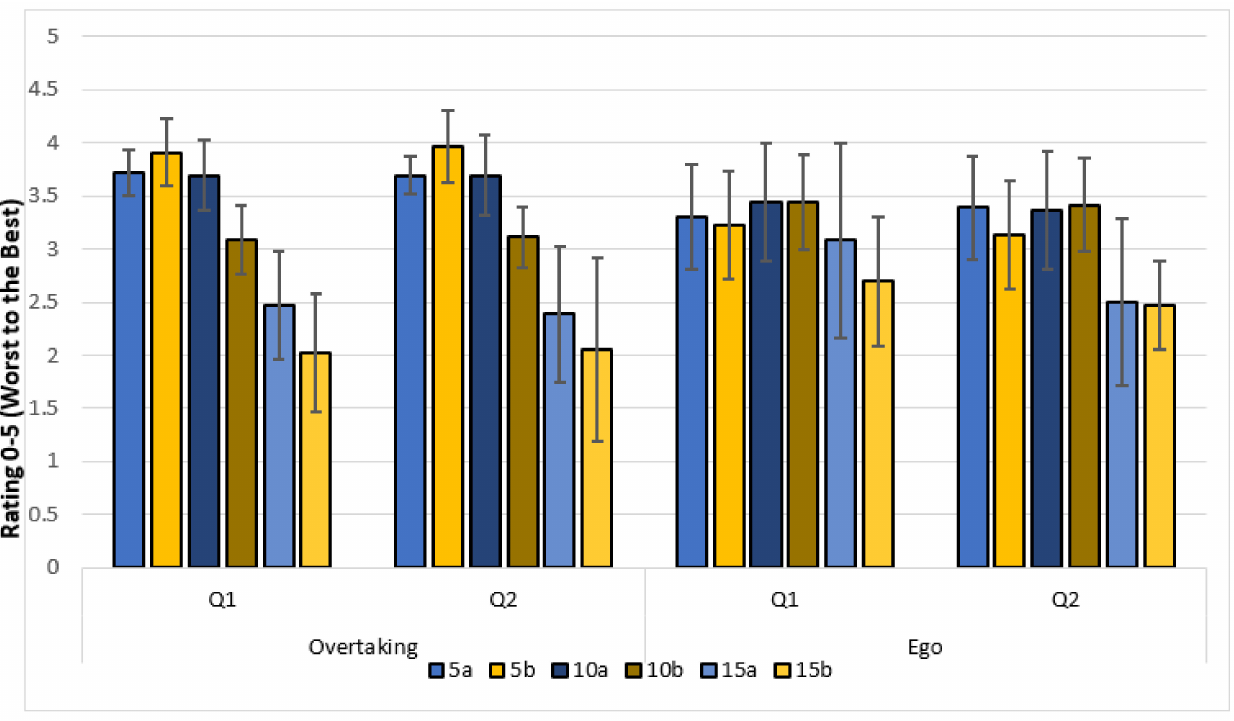
Figure 6. Subjective rating for understandability (a & b represent two contrast values, 2.00 and 1.48, whereas 5, 10, and 15 represent the distance values in